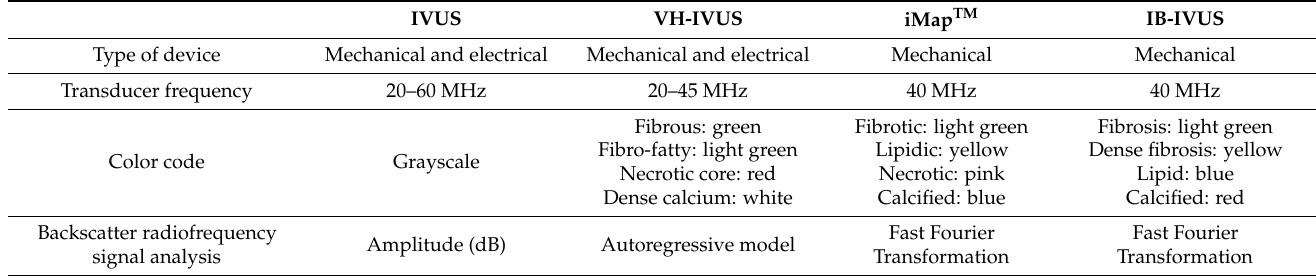
Table 1. A summary of IVUS and IVUS-based imaging